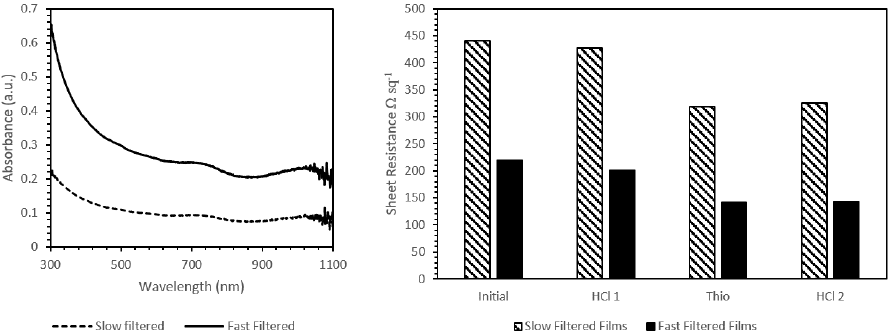
Figure 5. UV / Visible spectra and sheet resistance comparison for slow vs. fast-filtered SWCNT films.